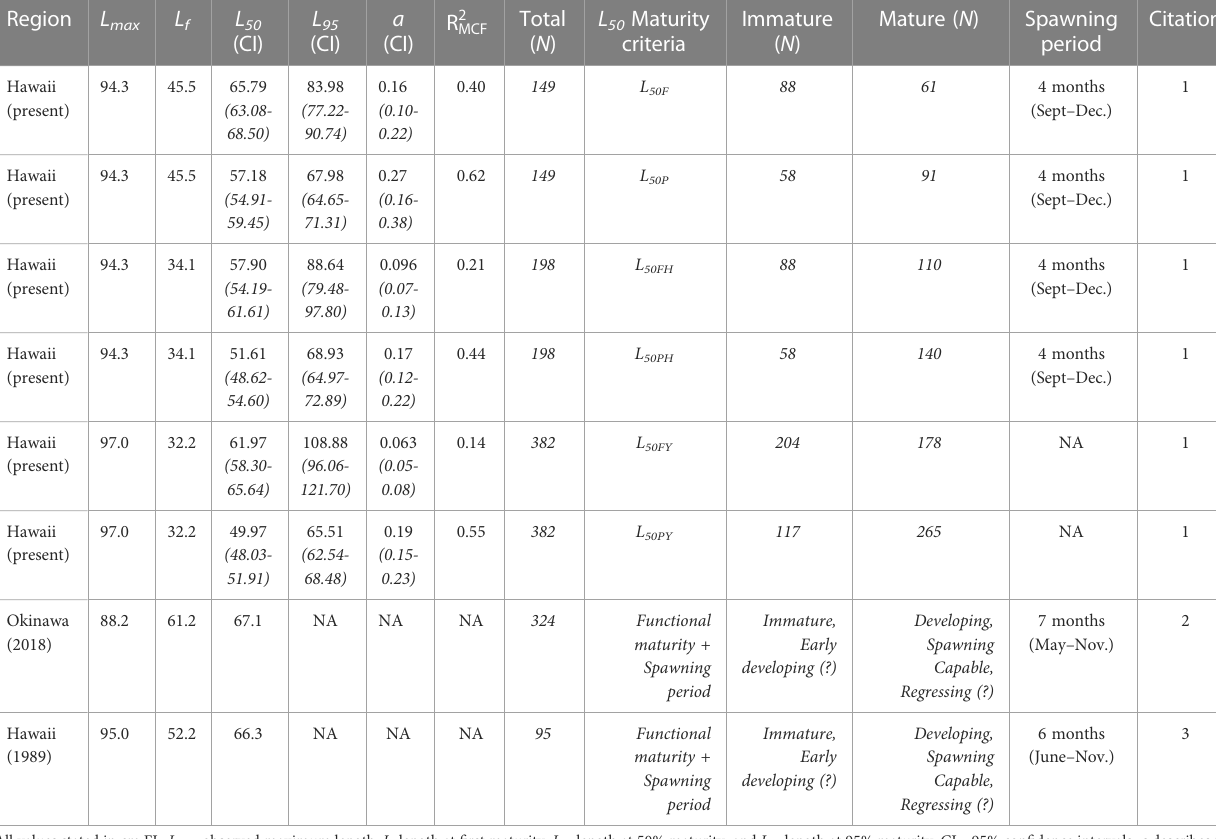
TABLE 4 Summary of reproductive characteristics for female Etelis coruscans , including previous studies.